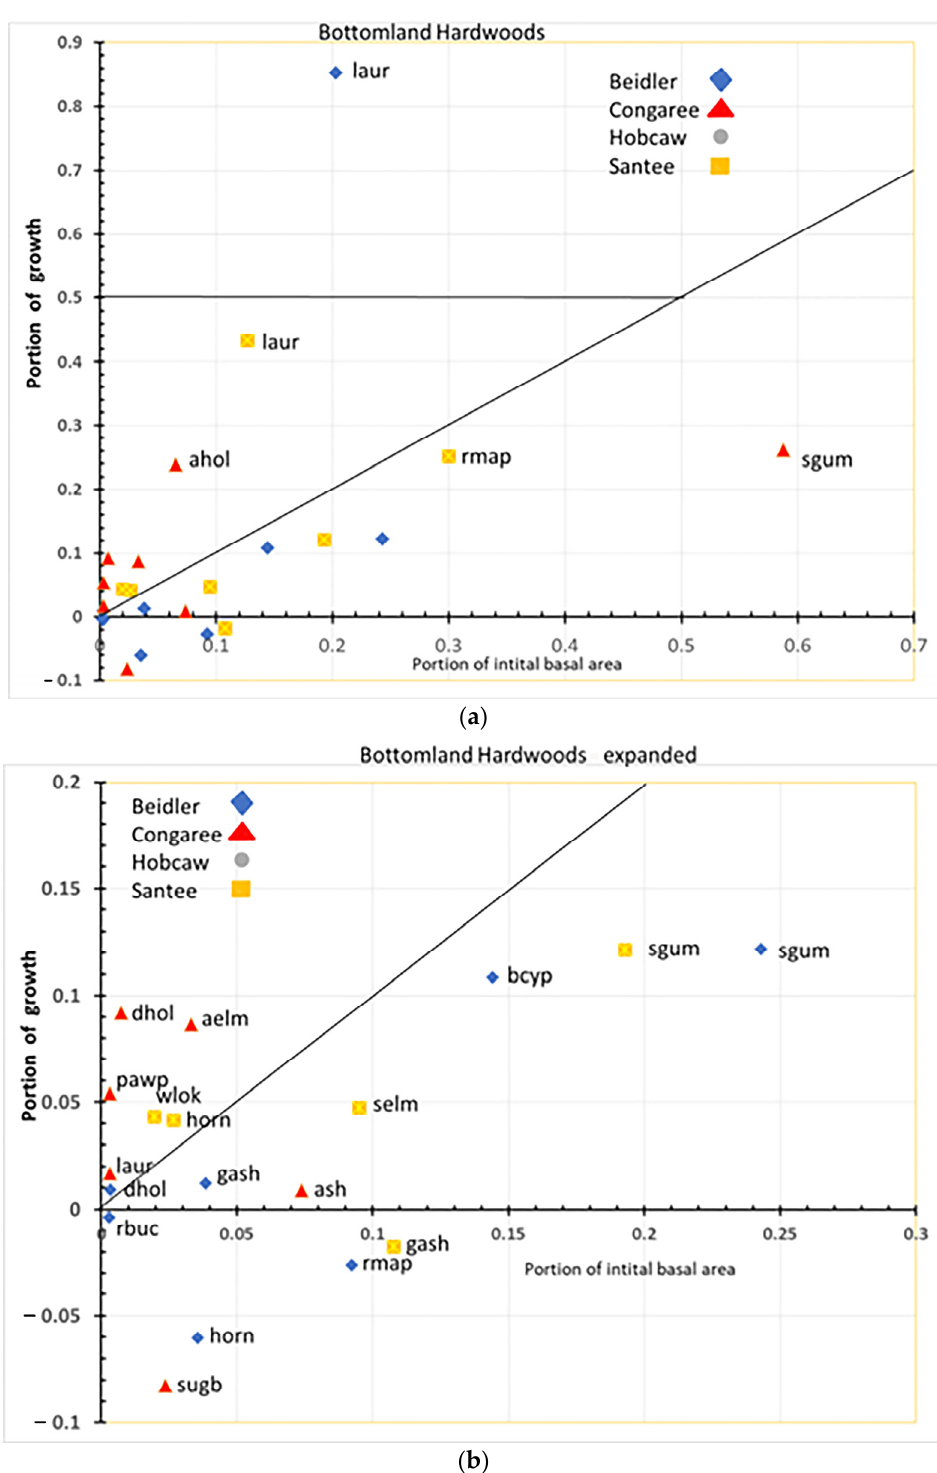
Figure 13. ( a ) Overall response of species in the bottomland hardwood type. Each species is labeled with four letter species code (Table 1) and symbol for site. ( b ) Enlargement of section of ( a ) (bottomland hardwood) near the origin in order to separate species codes.